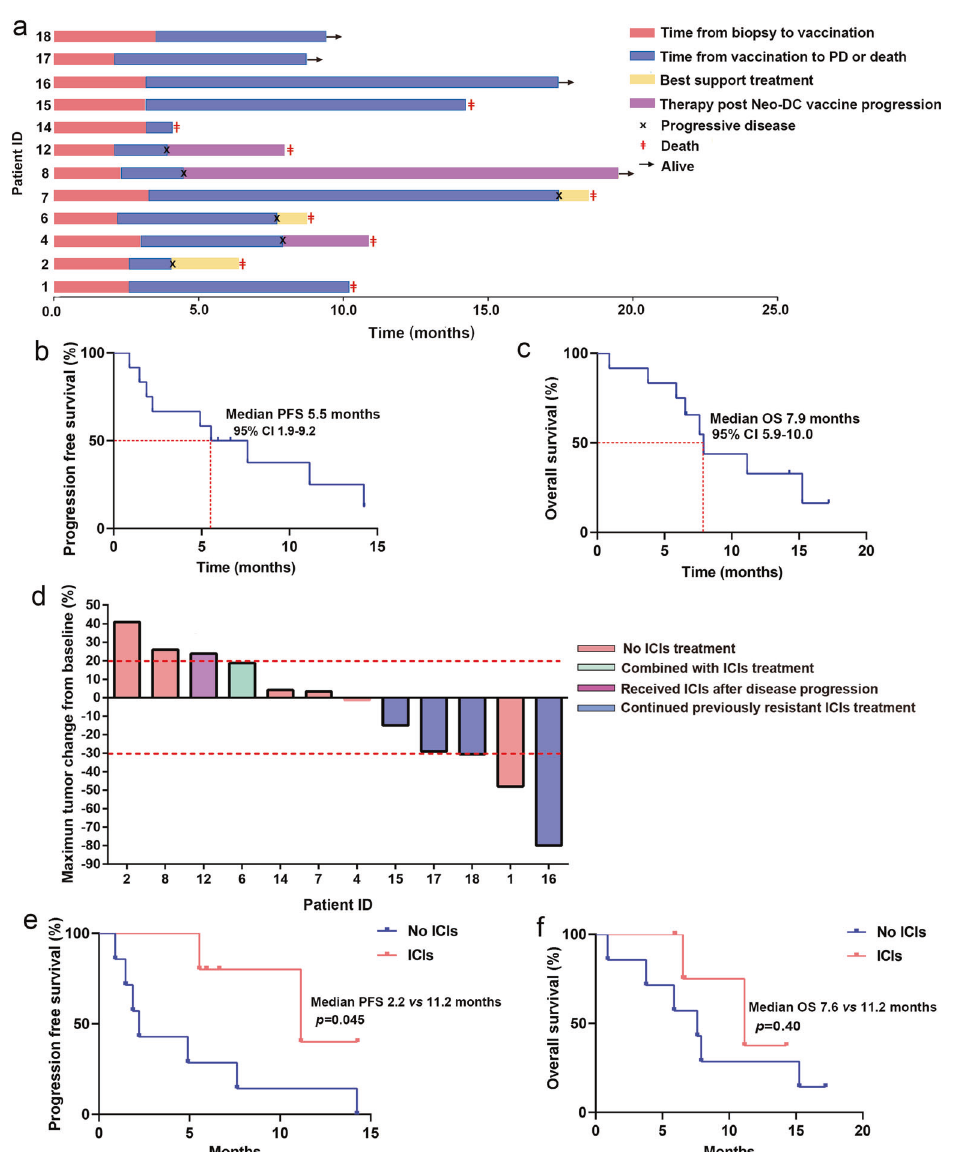
Fig. 2 Presupposition analysis of the clinical activity of Neo-DCVac in the treatment of advanced lung cancer. a Clinical event timeline for the 12 patients who received Neo-DCVac treatment, from biopsy until the time of death due to progressive disease (PD) or last follow-up time. b Progression-free survival (PFS) of patients treated with Neo-DCVac. c Overall survival (OS) of patients treated with Neo-DCVac. d Best observed response for 12 patients given Neo-DCVac with or without ICI treatment. e PFS of patients treated with Neo-DCVac or Neo-DCVac and ICIs. f OS of patients treated with Neo-DCVac or Neo-DCVac and